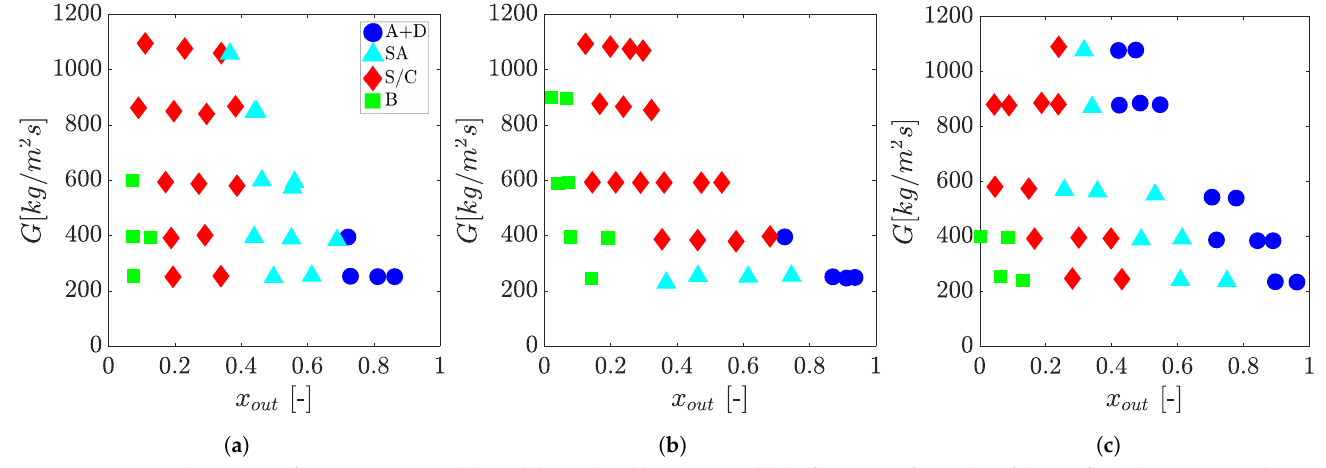
Figure 8. Flow maps for Geometry A ( a ), B ( b ), and C ( c ): ■ B = Bubbly flow, ◆ S/C = slug/churn flow (intermittent), ▲ SA = Semi-annular flow, ● A + D = Annular flow with incomplete